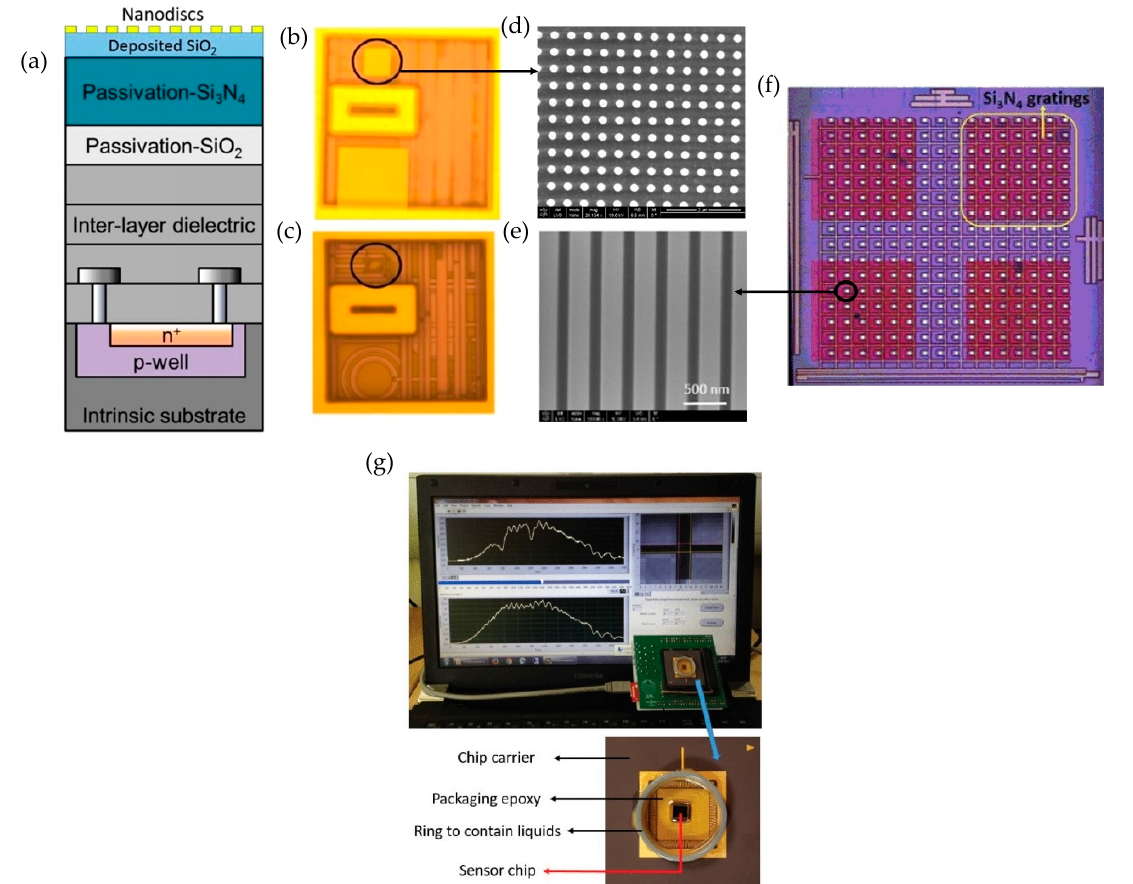
Figure 10. ( a ) Cross section schematic of the complementary metal oxide semiconductor (CMOS) PD chip with integrated gold nanodisc array. ( b , c ) Microscopic images of the CMOS PD chip. ( b ) with and ( c ) without integrated gold nanodisc arrays. The PD area is encircled in both cases and have dimensions of only 6 × 8 µm. ( d ) SEM image of the gold nanodiscs integrated on top of the CMOS PD chip. ( e ) SEM image of the silicon nitride gratings fabricated on top of the CMOS PD chip. ( f ) Microscopic image of the silicon nitride gratings integrated with the CMOS PD chip having an array of PDs. The four dark areas, one of which is encircled shows silicon nitride gratings. The PD pixels between the silicon nitride gratings were used as a reference. ( g ) Packaged sensor chip connected with the laptop with readout displayed on the laptop screen. ( a – d ) reprinted with permission from [74]. Copyright © American Chemical Society (ACS) (2016). ( e – g ) reprinted with permission from [76]. Copyright © IEEE (2018).